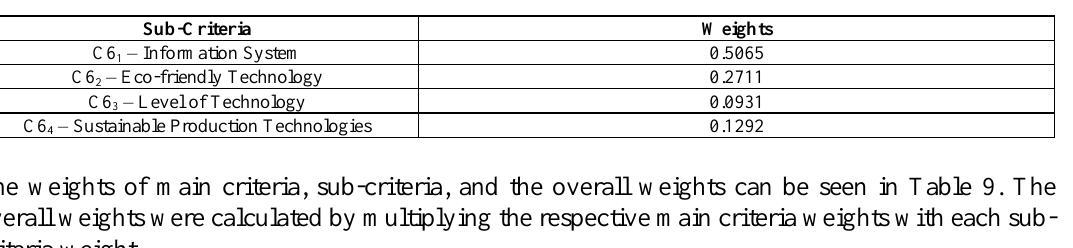
Table 8. Weights of sub-criteria within technological ability